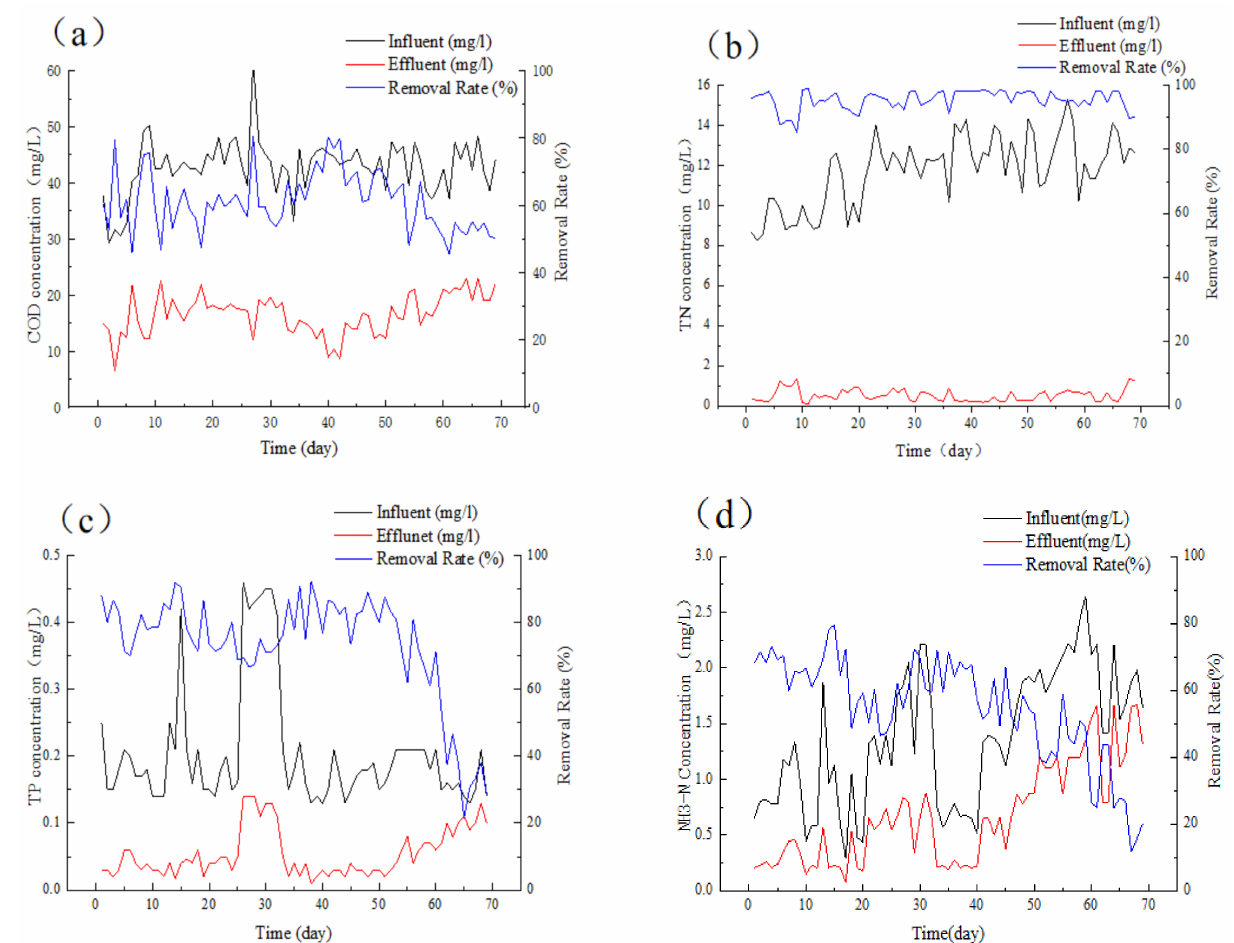
Figure 5. Influent and effluent concentration and removal efficiency of ( a ) COD, ( b ) TN, ( c ) TP, and ( d ) NH 3